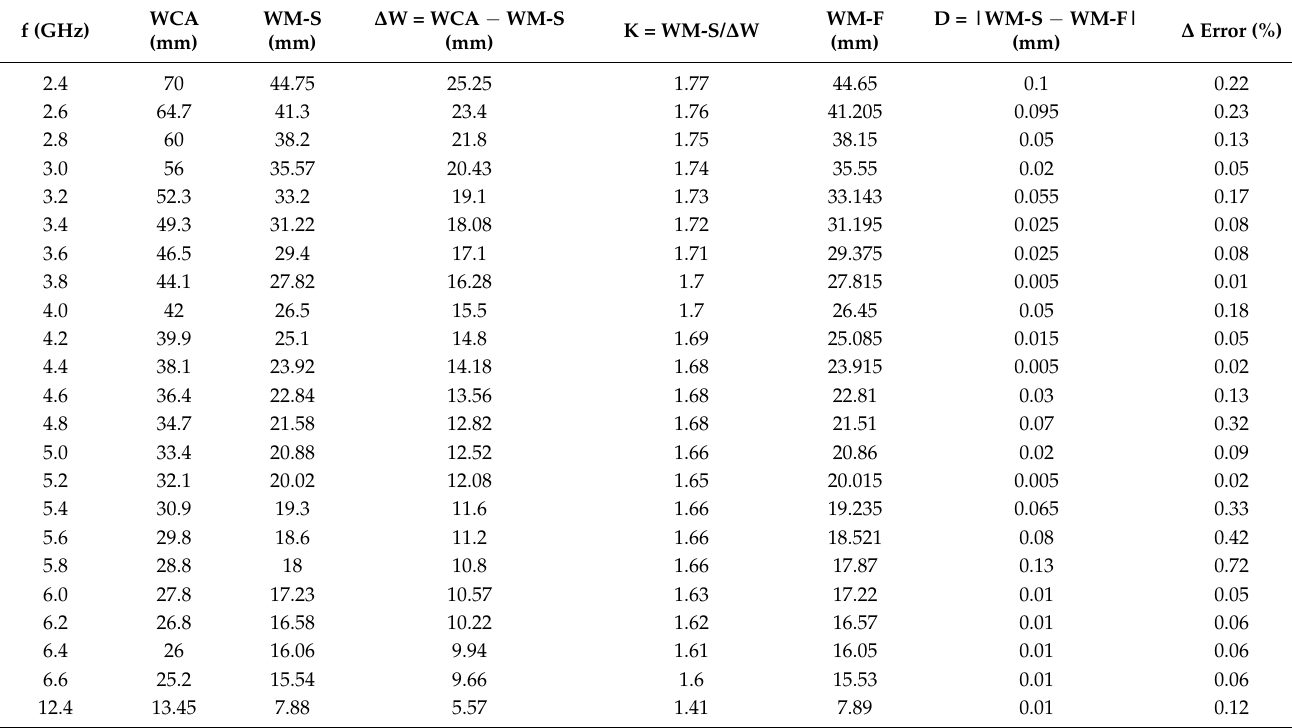
Table 5. Patch width estimation on denim substrate using CMA.